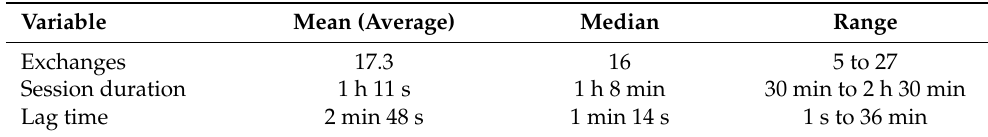
Table 2. Time variables during text sessions (n =